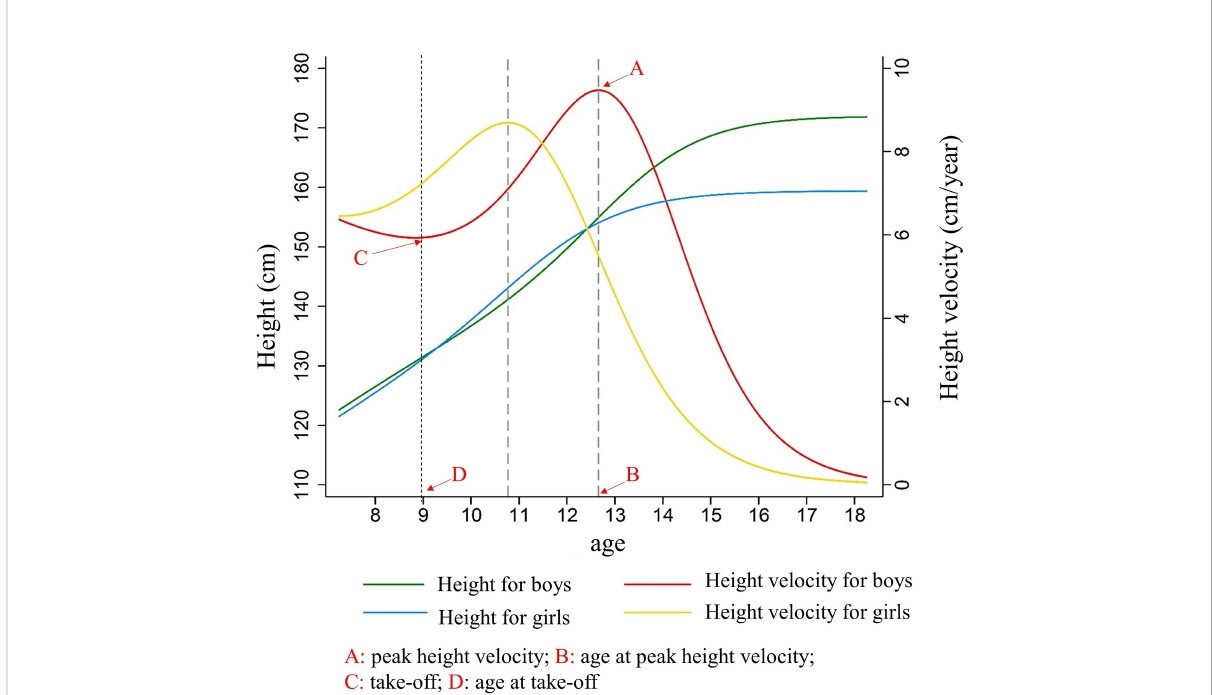
FIGURE 1 The characteristics of height growth patterns in puberty between boys and girls. Description of results in fi gure above: Because girls entered the height spurt earlier and the height growth rate was higher than that of boys at the same period. Girls began to catch up in height and surpassed boys at 9.2 years old, forming the fi rst height crossover. As boys began to enter the height spurt, the growth rate of height accelerated, and the duration and PHV of height spurt exceeded that of girls, so that the height of boys exceeded that of girls at age of 12.6 years, forming the second crossover of height. After that, the height gap between boys and girls continued to expand, and the height of the boys in the late adolescence (171.8 ± 6.1 cm) was signi fi cantly higher than that of girls (159.45 ± 5.8 cm) ( t = 117.39, P <